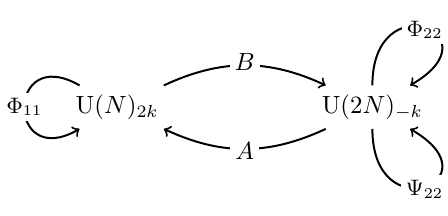
Figure 5 . The 3d model given by the higher- n Laufer